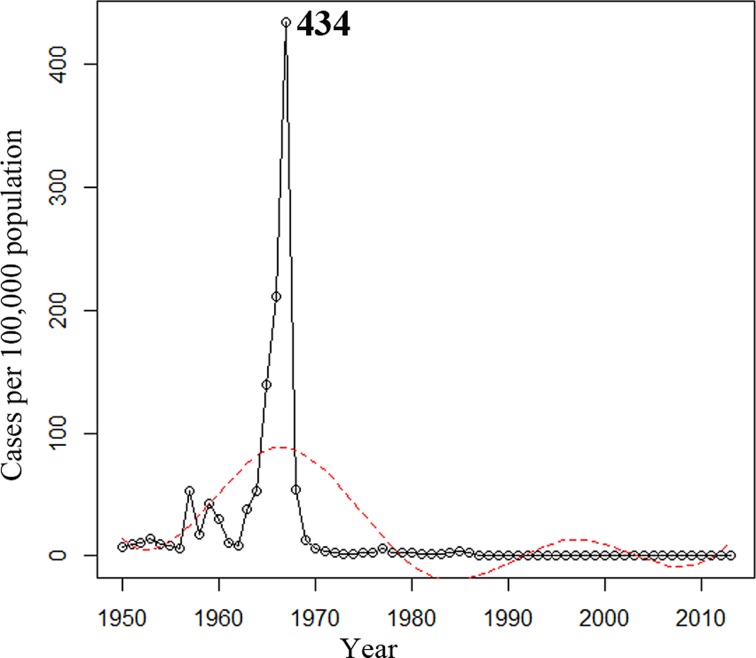
Annual incidence of reported cases of meningococcal disease in Shanghai from 1950 to 2013.The trend was analyzed using regression splines (red dotted line).